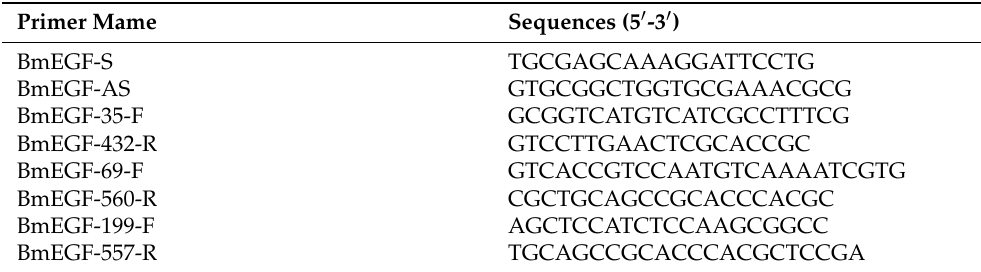
Table 1. List of primers for PCR amplification.